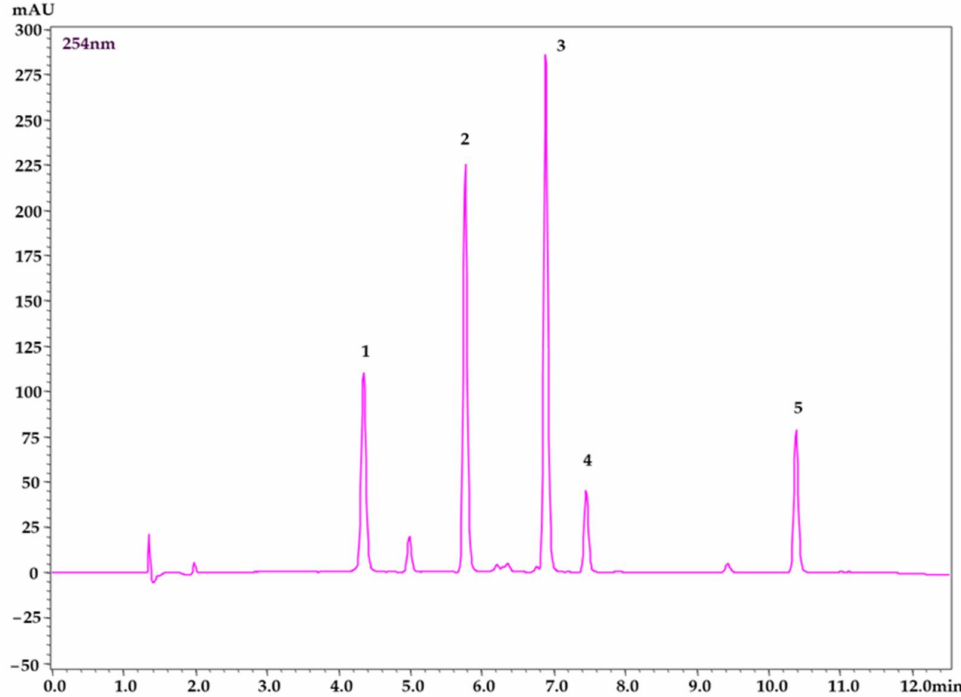
Figure 2. Chromatogram of mixed standard solution using YMC Triart C18 ExRS (150 × 4.6 mm, 5 µ m particle size) at a universal wavelength of 254 nm. (1) chlorogenic acid, (2) rutin, (3) quercitrin, (4) phloridzin, (5)